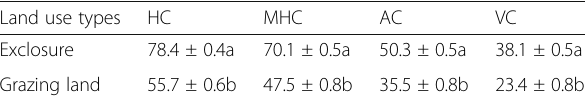
Table 3 Root length colonization (%) of AMF between exclosures and open grazing lands